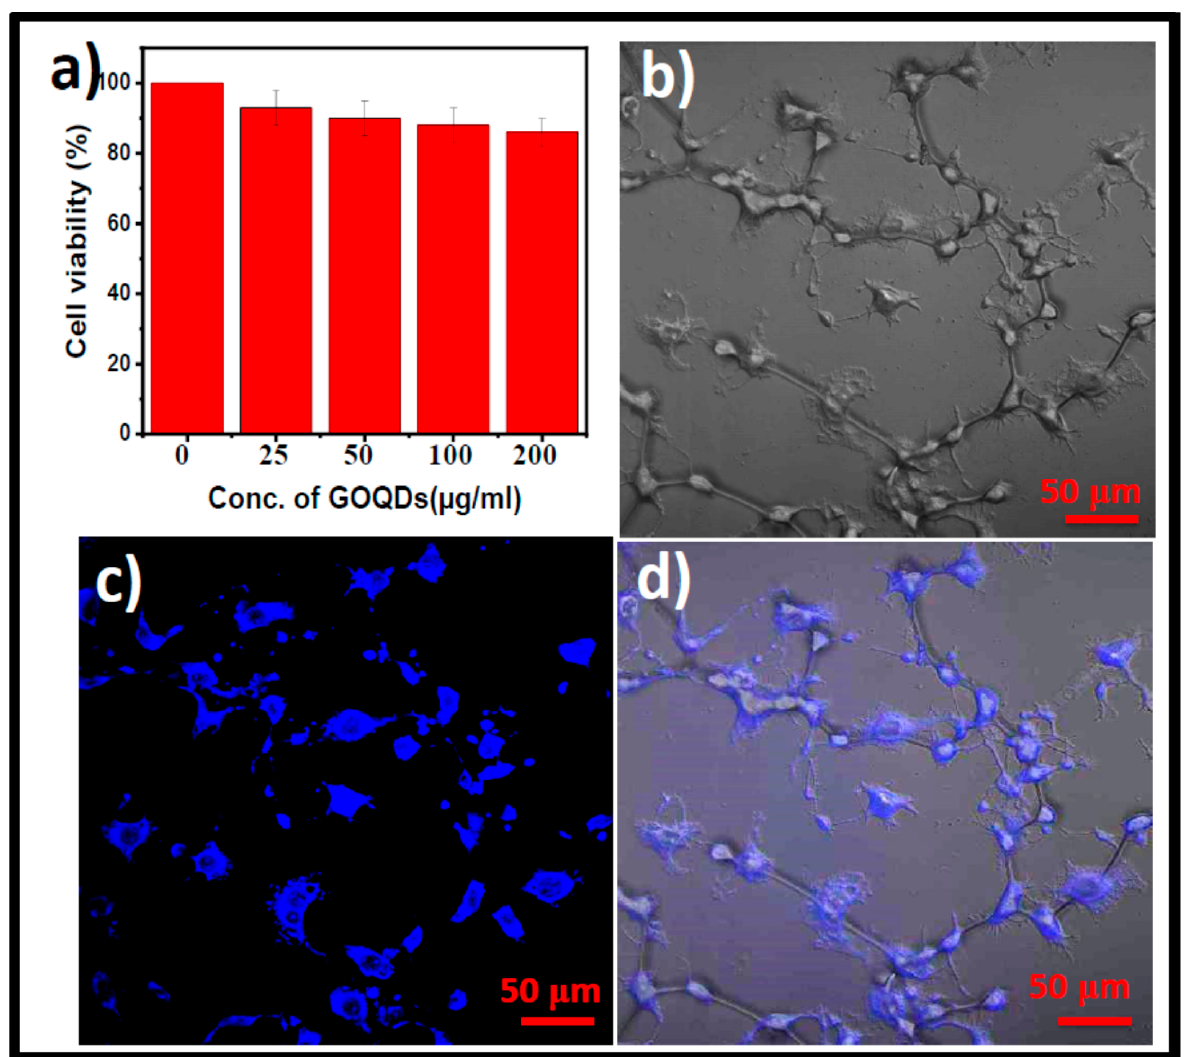
Figure 5. ( a ) Cell viability assay of GOQDs at different concentrations. Confocal fluorescence images of GOQDs in CT26 cells. ( b ) Bright-field image. ( c ) Blue emission of GOQDs within the cells recorded at 405 nm excitation. ( d ) The overlay of bright-field ( b ) and fluorescence ( c ) images. (The concentration of GOQDs used was 200 µg/mL).